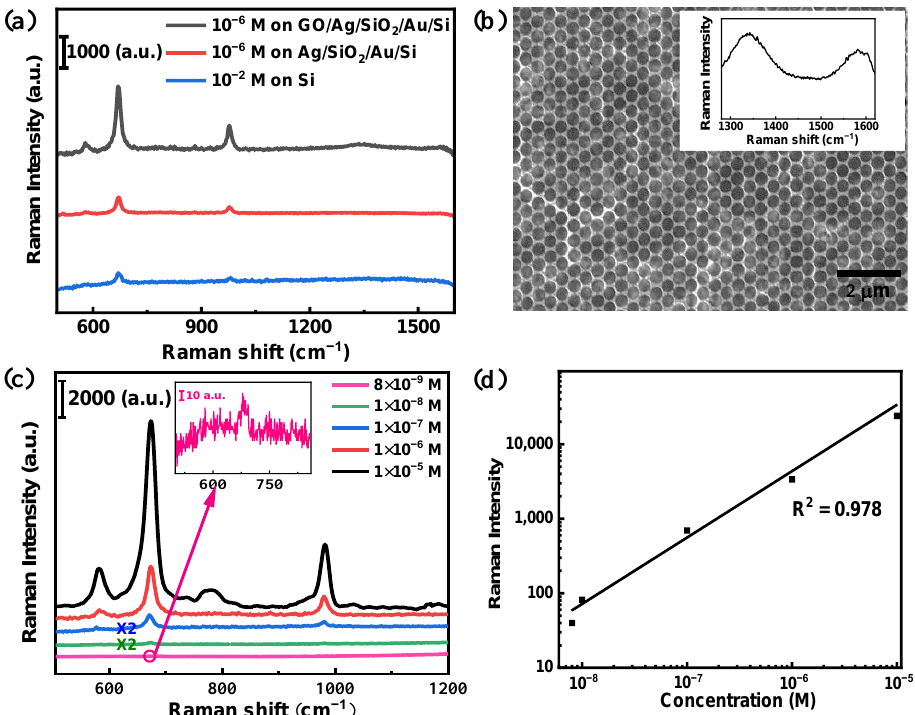
Figure 6. ( a ) Measured SERS spectra with 10 − 6 M melamine on the GO/Ag/SiO 2 /Au/Si substrate, the Ag/SiO 2 /Au substrate, and 10 − 2 M melamine on the Si substrate, respectively. ( b ) SEM image of GO-coated Ag metasurface. The inset shows the Raman spectrum of GO on the metasurface. ( c ) Measured SERS spectra for melamine with different concentrations from 1 × 10 − 5 M to 8 × 10 − 9 M on the GO/Ag/SiO 2 /Au/Si substrate. The inset illustrates the Raman peak of trace melamine with a concentration of 8 × 10 − 9 M at 671 cm − 1 . ( d ) Raman intensity of melamine at 671 cm − 1 as a function of different concentrations in log scale.